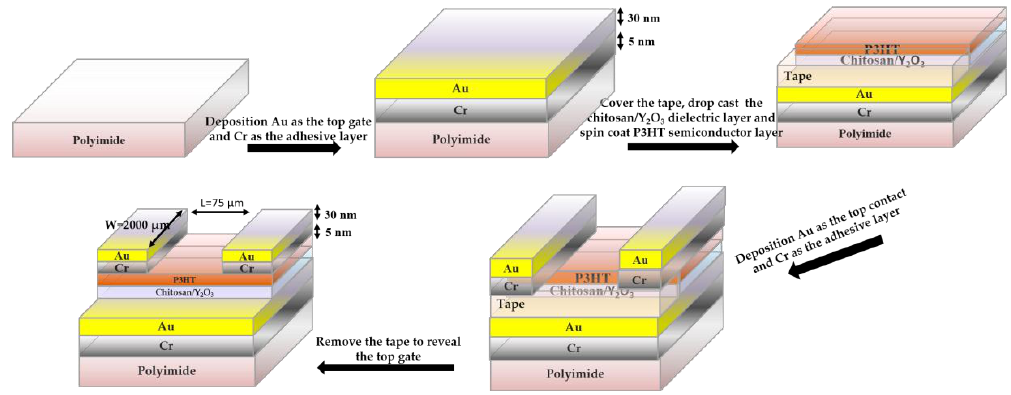
Figure 1. The fabrication process of the bottom-gate top-contact flexible organic thin-film transistor.